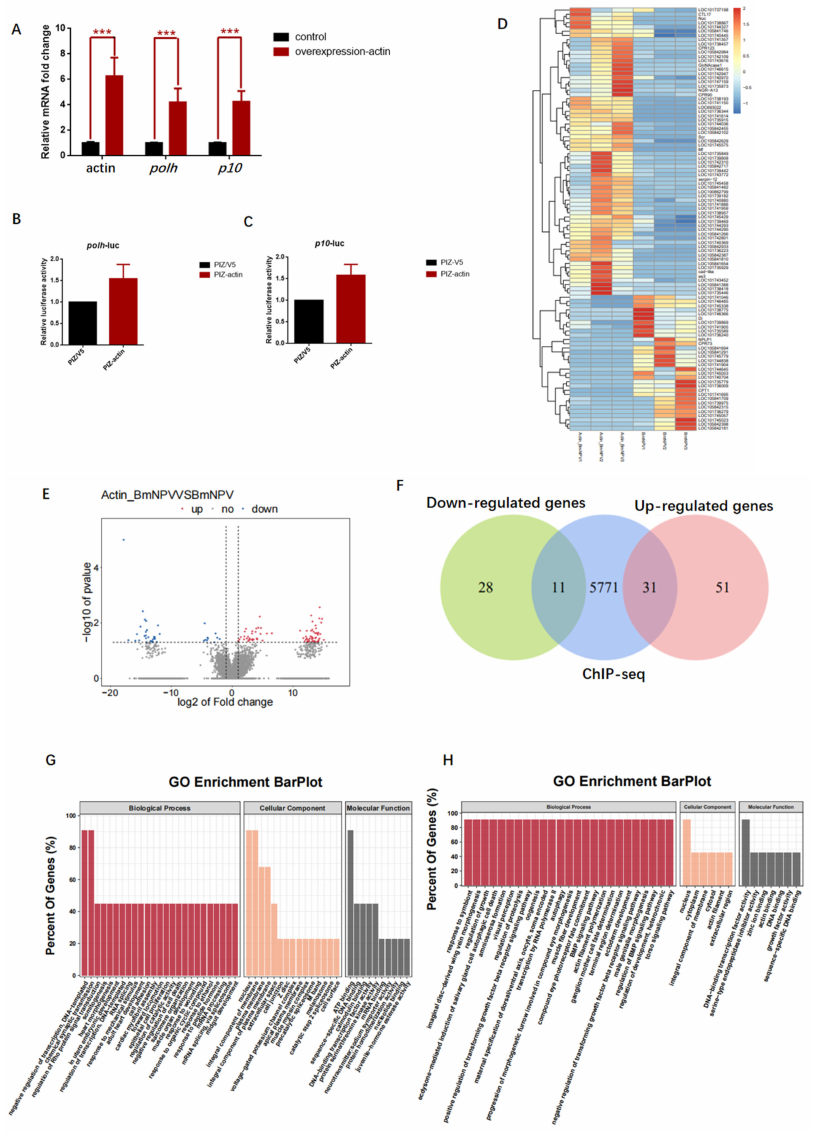
Figure 6. Overexpression of actin stimulates polh and p10 transcription. ( A ) Quantitative real-time PCR analysis of actin, polh , and p10 in BmN cells overexpressing actin or empty vector (Ctrl) ( n = 3, ***, p < 0.001). ( B , C ) The relative luciferase expression activity under the control of polh and p10 . ( D ) Heatmap showing the fold change for differentially expressed host genes in cells overexpressing actin and control cells expressing empty vector. ( E ) Scatter plot of global mRNA expression in cells overexpressing actin and control by polyA(+) RNA-seq. Number of up- and downregulated mRNAs is shown. ( F ) Venn diagram representing overlap between differentially expressed genes (up and down) and the enrichment host genes of actin from ChIP-seq. ( G , H ) The functional annotations of the overlapped genes in ( E